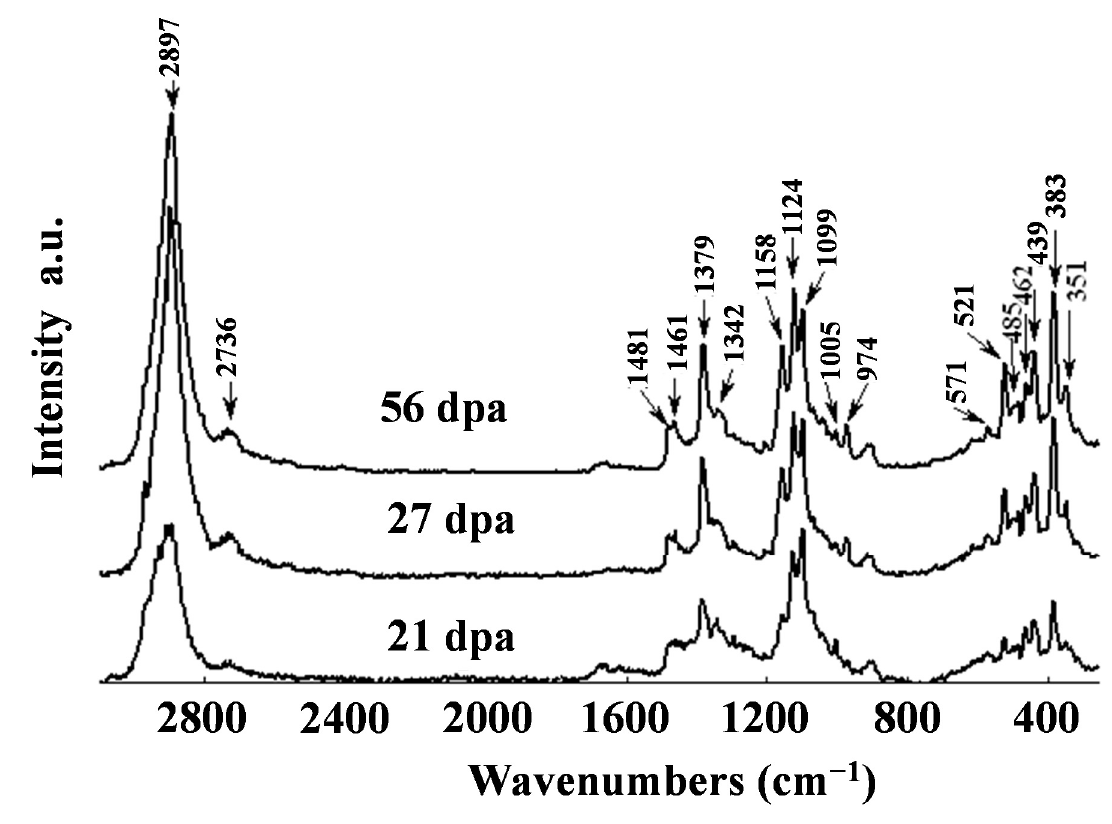
Figure 3. Raman spectra of cross-sections of fibers at different developmental stages: 21 dpa, 27 dpa and 56 dpa. The spectra are shifted vertically for